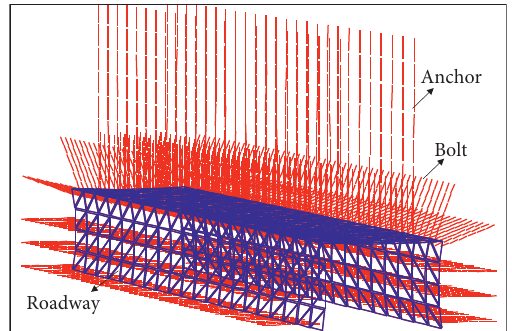
Figure 16: The bolt support structure of the roadway.